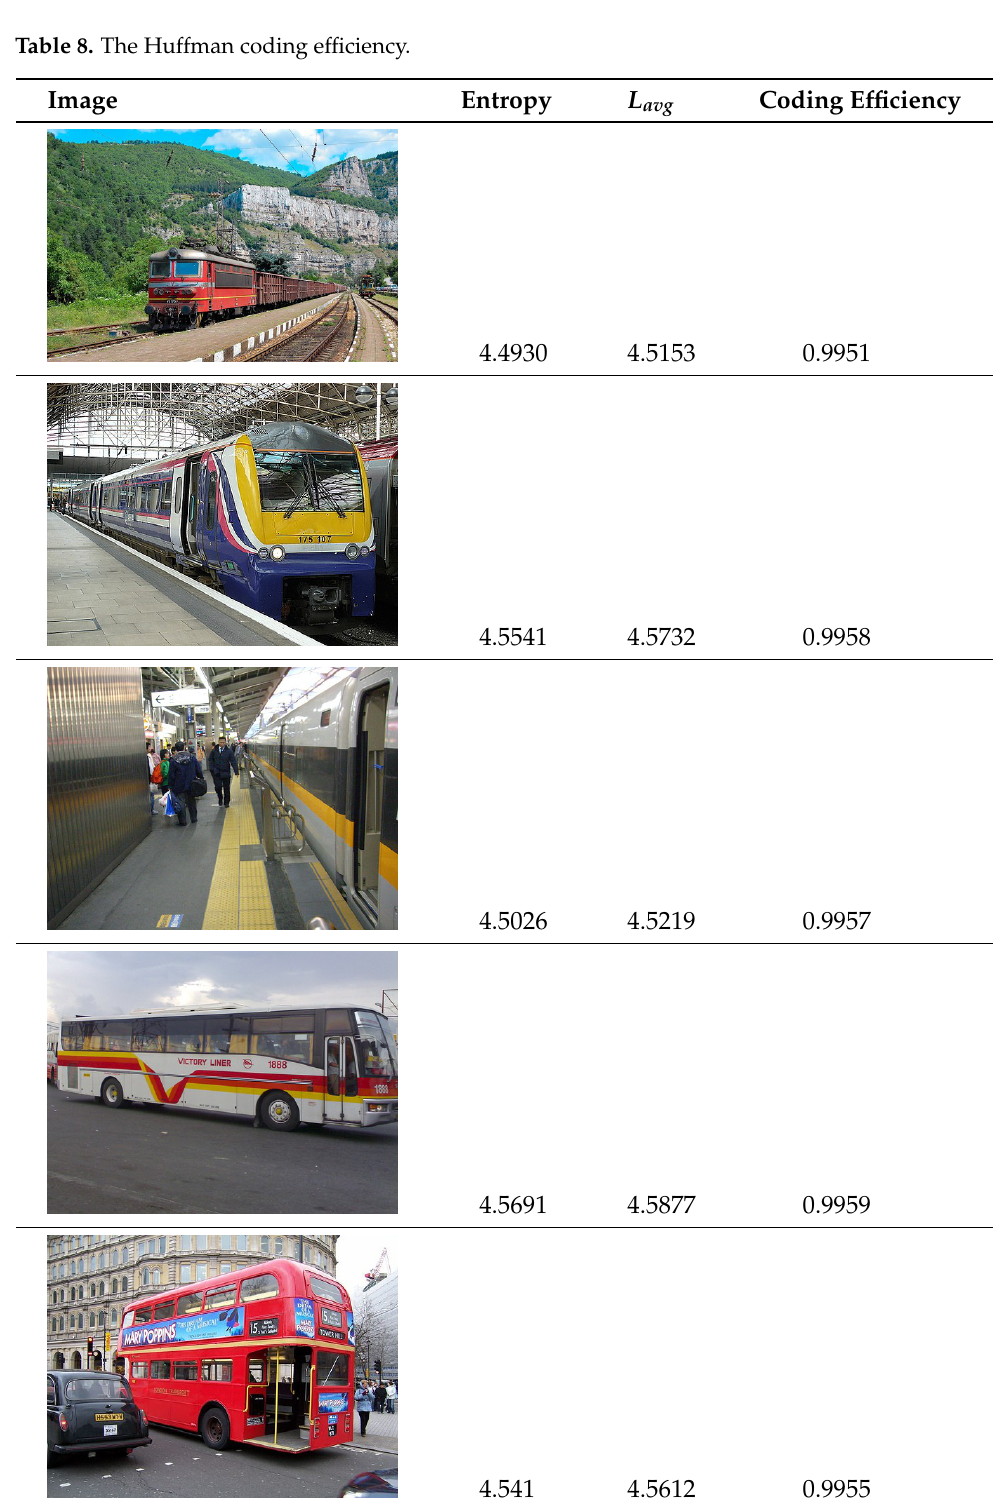
Table 8. The Huffman coding